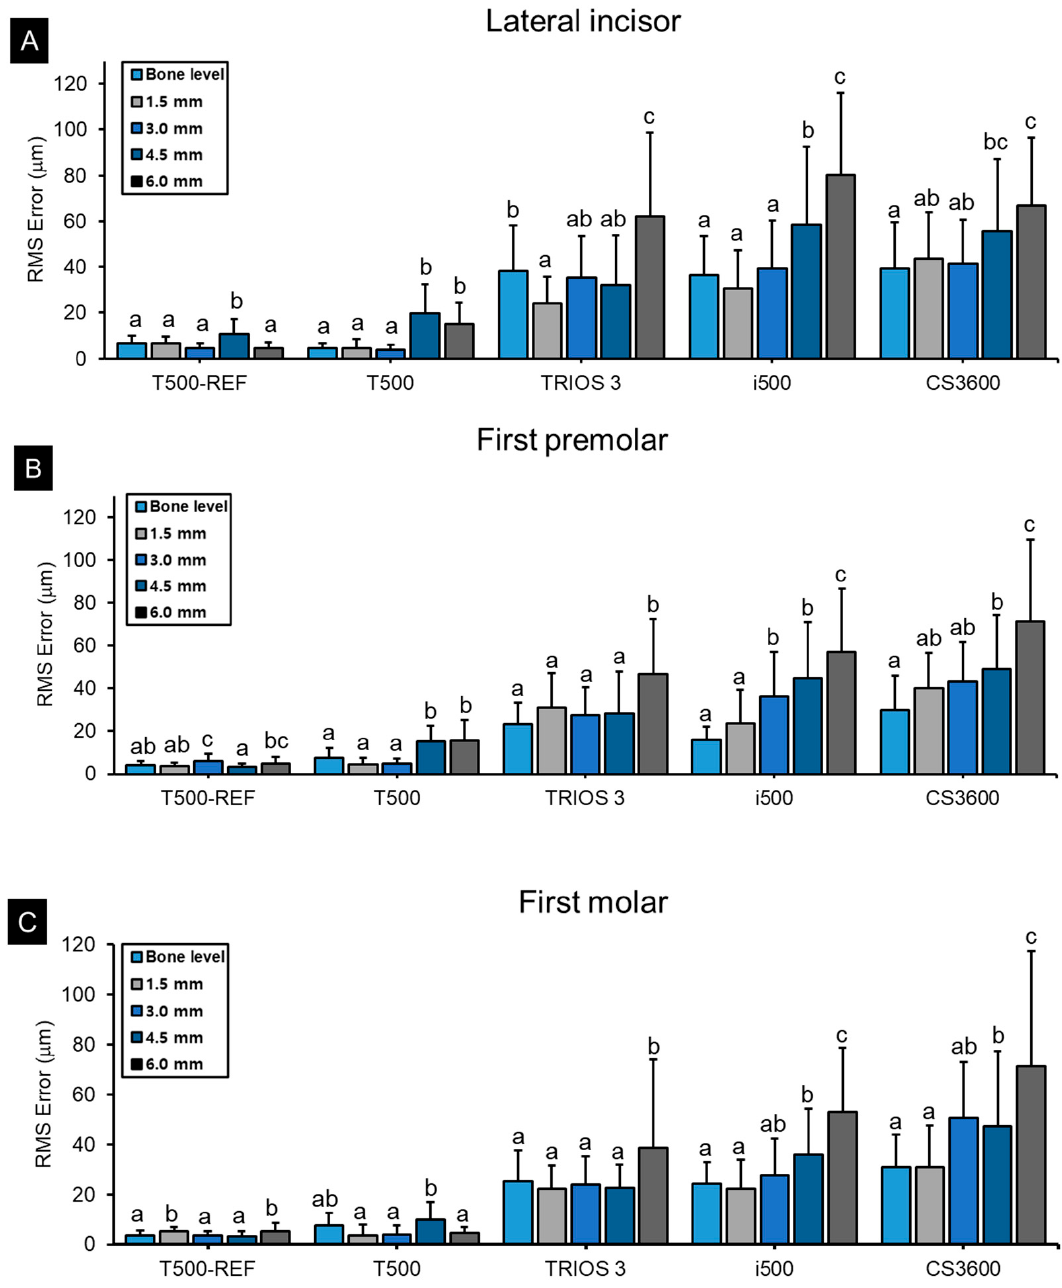
Figure 9. Precision according to tooth position: ( A ) lateral incisor; ( B ) first premolar and ( C ) first molar. Different lowercase letters indicate significant differences within each scanner group. Data are mean and standard deviation values.